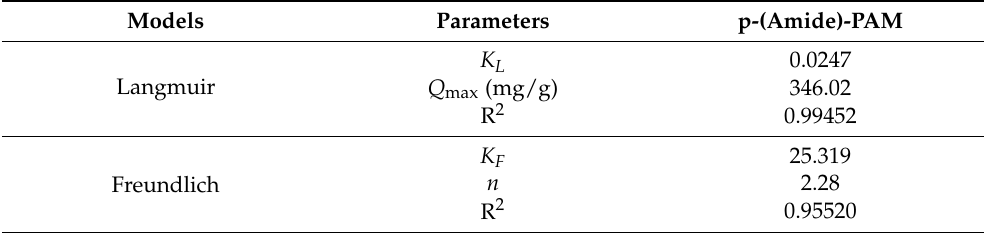
Table 2. Fitting parameters of the Langmuir model and Freundlich